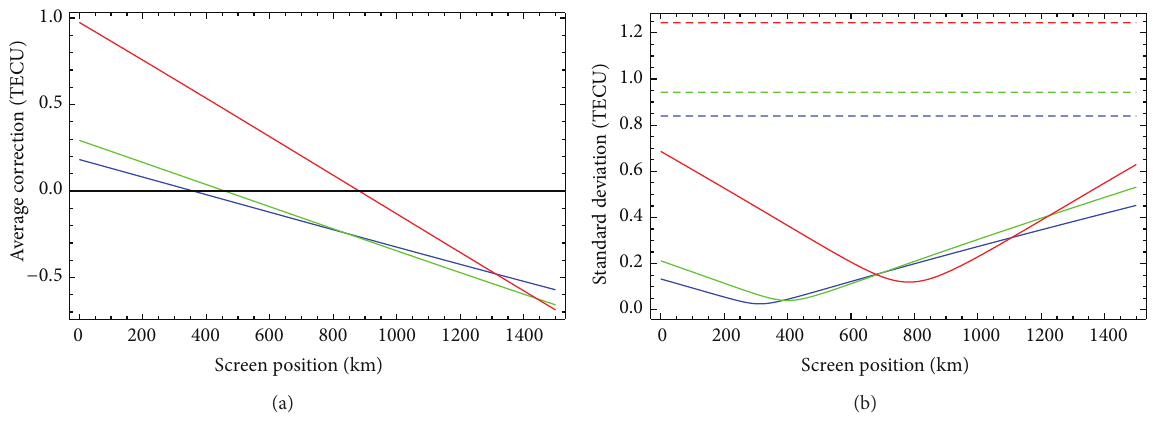
Figure 5: The same as in Figure 3 for geometry-free combination